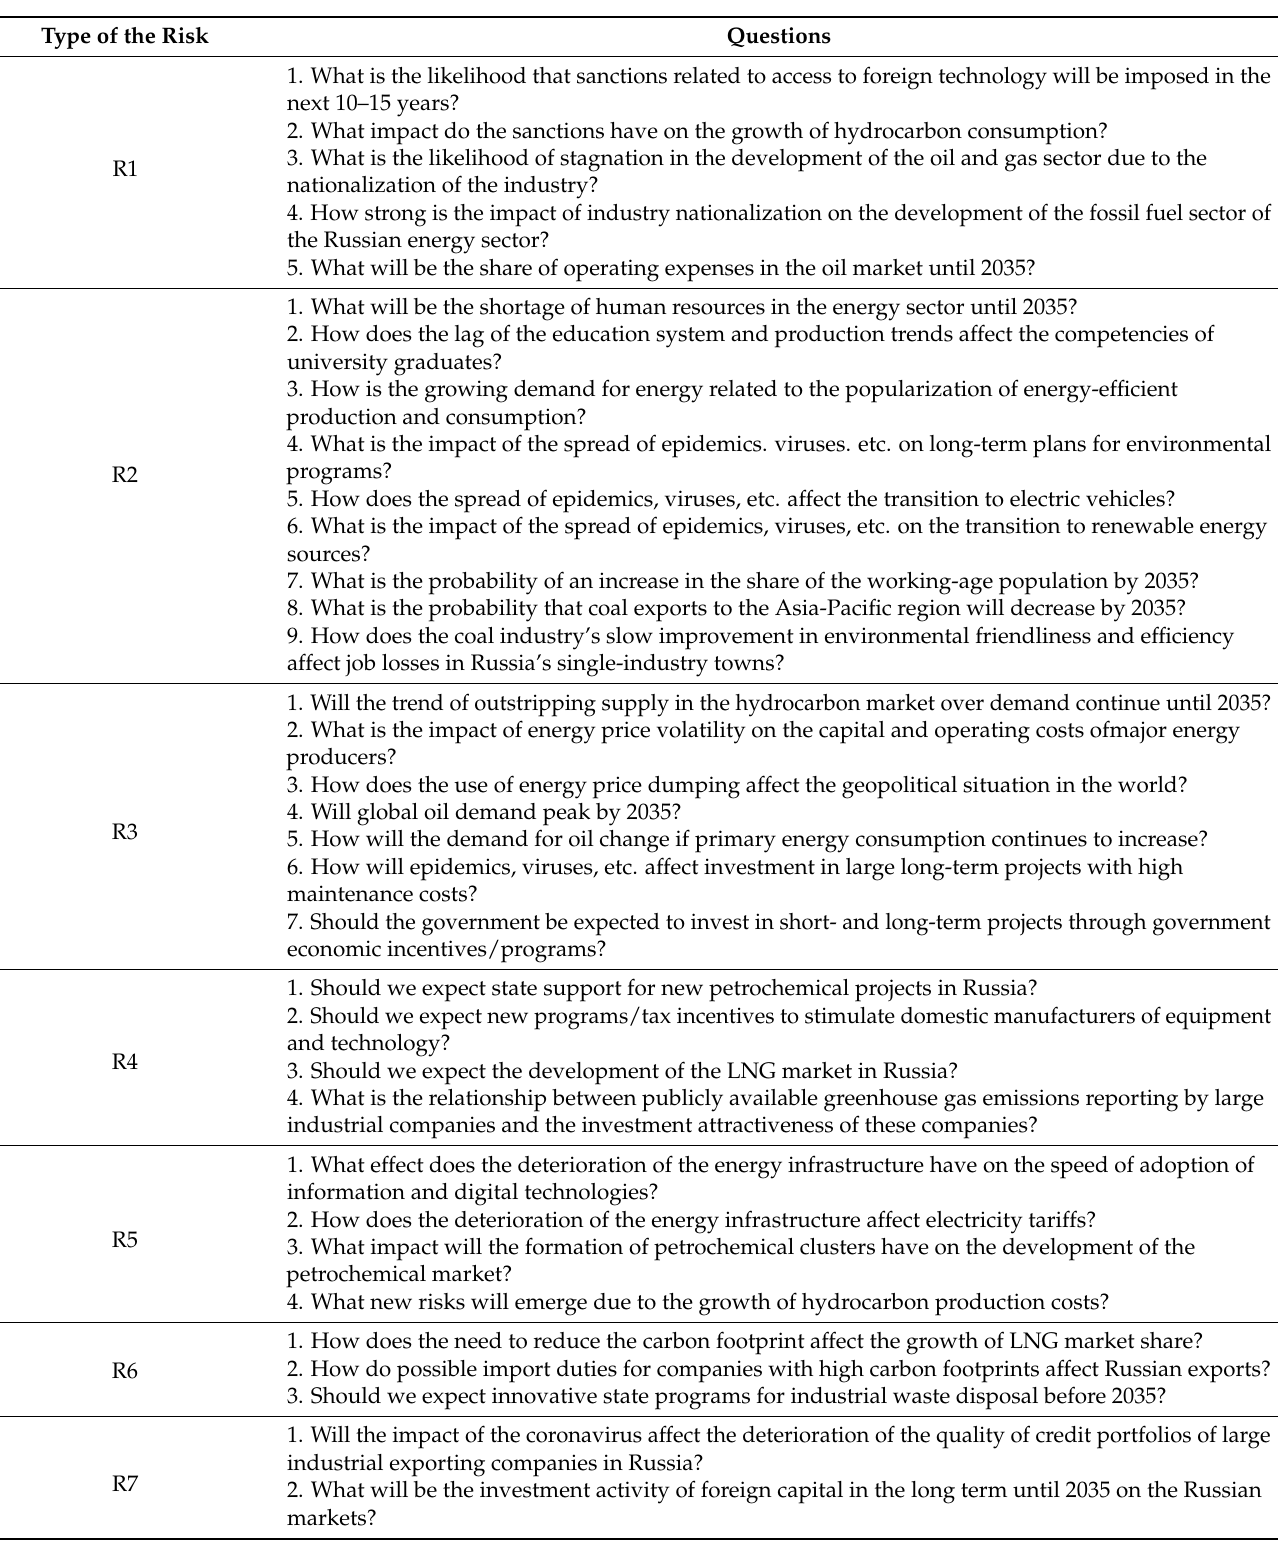
Table 3. The questions of the